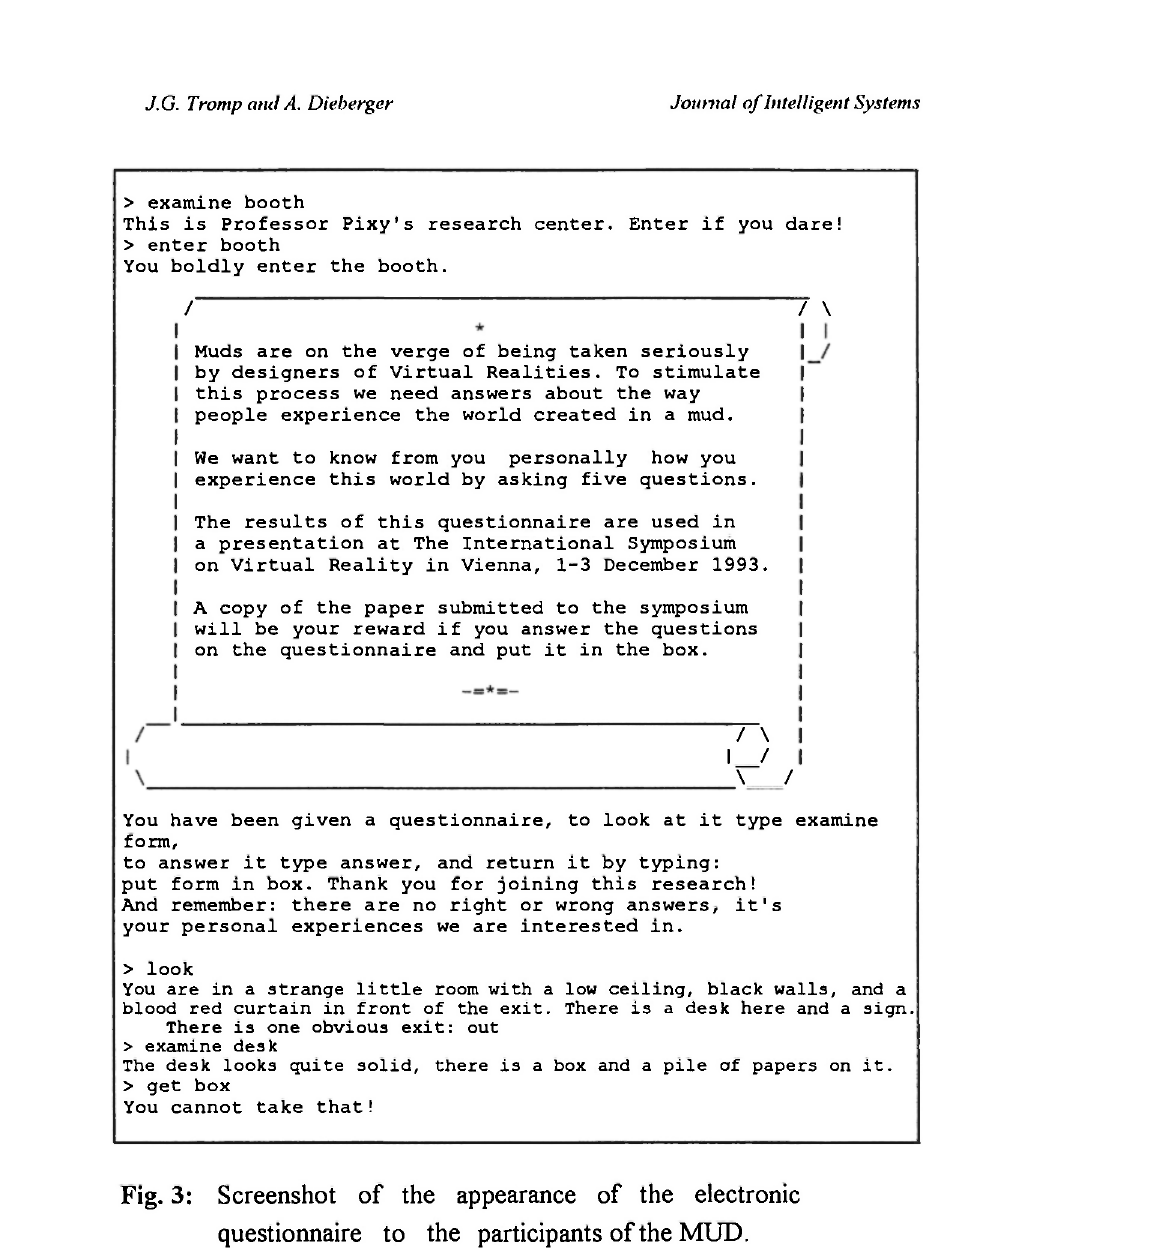
Fig. 3: Screenshot of the appearance of the electronic questionnaire to the participants of the MUD.